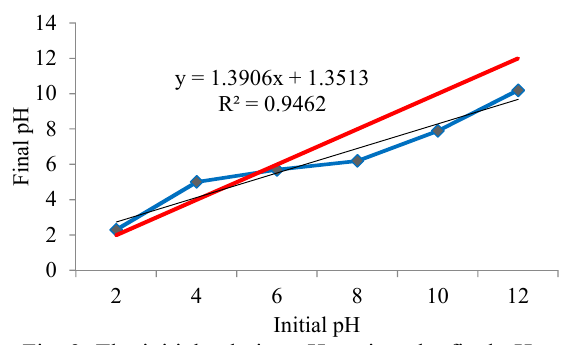
Fig. 3. The initial solution pH against the final pH in order to determination the pH zpc MCPAC